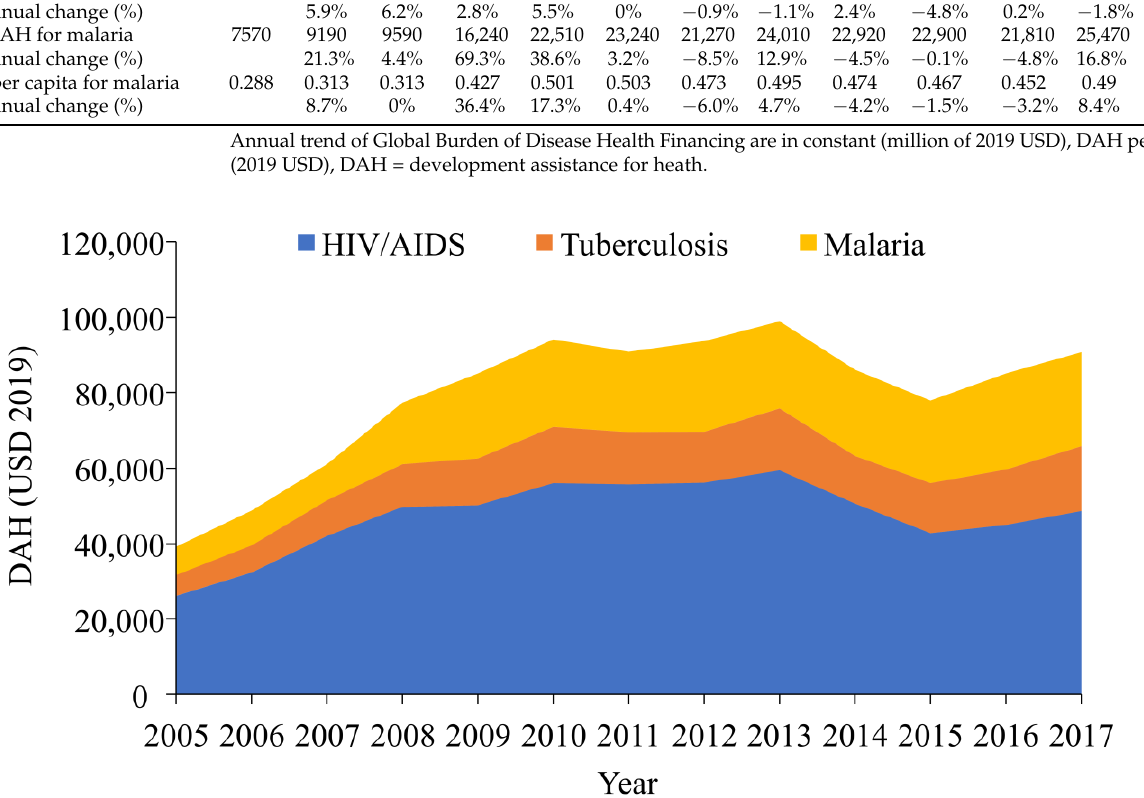
Figure 1. Stacked area chart, development assistance for health to HIV/AIDS, TB, and malaria, 2005 – 2017 (unit of y-axis: millions of 2019 USD, DAH = development assistance for health). Figure 2 demonstrates the trend of DAH per capita for each disease. DAH per capita for HIV/AIDS, TB, and malaria showed a rapid increase in 2007 and remained almost con- stant until 2014, then abruptly decreased from 2014. HIV/AIDS received the highest